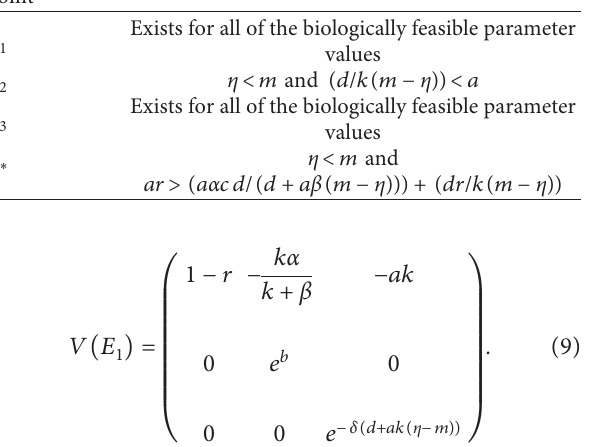
Table 1: Existence conditions for fixed points of system (2). Equilibrium point